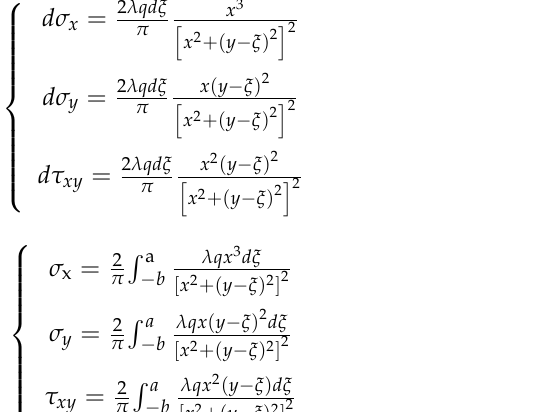
Figure 3. Force model of bottom plate under residual coal column pressure. The stress induced by the microset load dF = λ qd ξ at any point M in the half-plane body is Equation (1), and integration over the range − b to a yields Equation (2), where ξ is the scale on the y -axis and λ is the stress concentration factor.